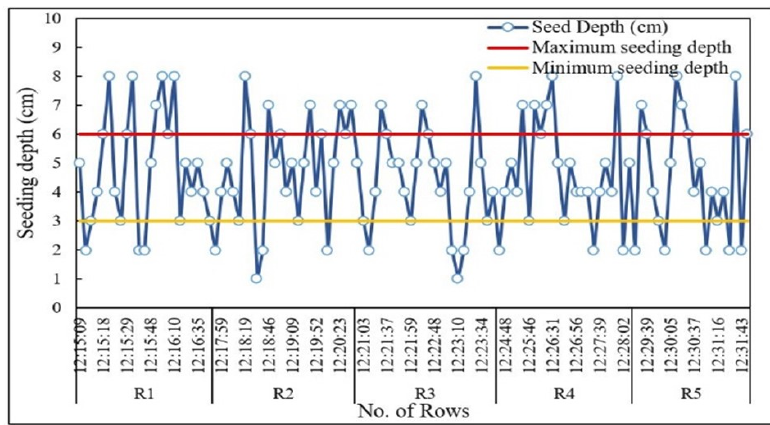
Figure 1. Seeding depth range without SDCS during wheat sowing